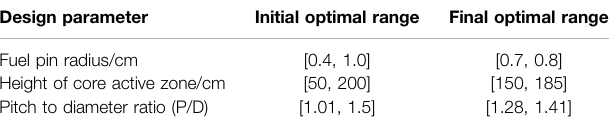
TABLE 8 | Initial and fi nal optimal range of design parameters for URANUS.